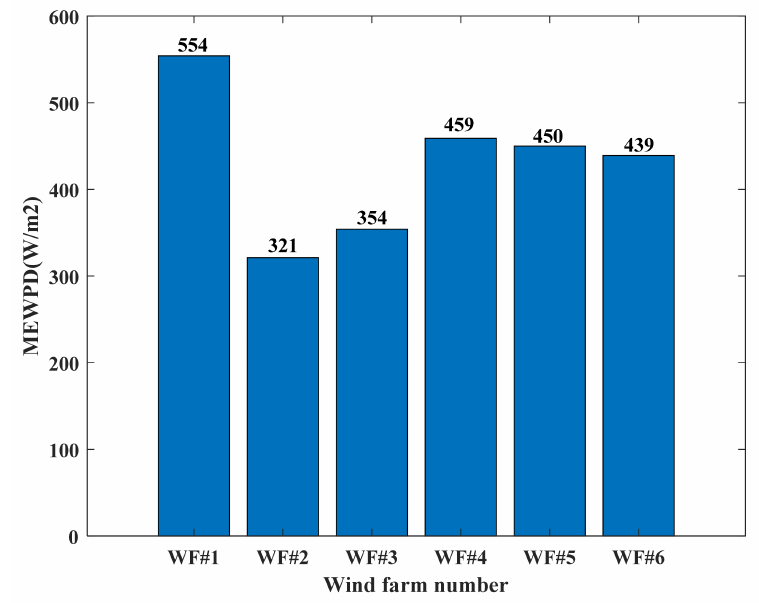
Figure 5. The calculation results of MEWPD of wind